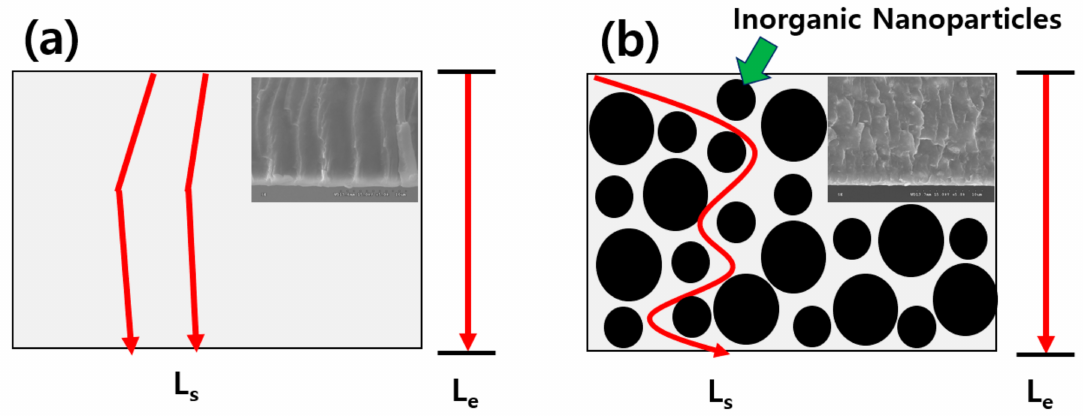
Figure 7. Comparison of geometrical tortuosity of ( a ) Nafion 112 and ( b ) NZT13 membranes (inset: the cross-sectional SEM images brought from Figure 2).